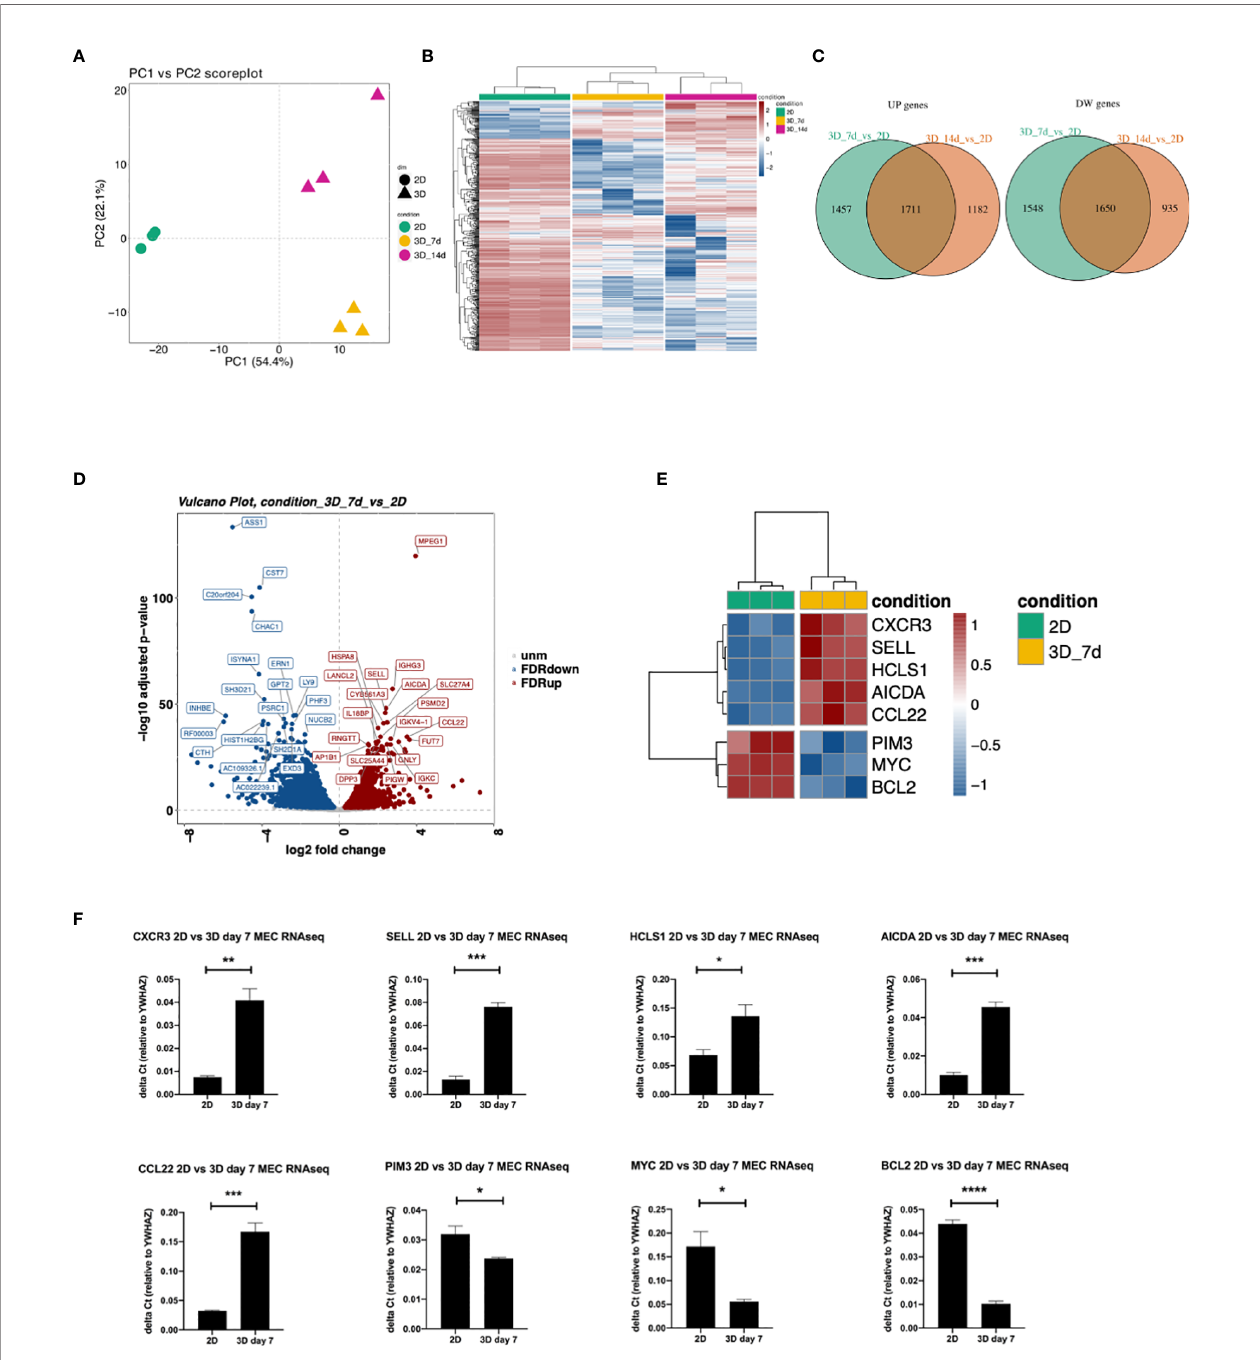
FIGURE 4 | Differences in gene expression between 3D bioprinted and 2D cultured MEC1 cells: clustering analysis and top genes validation. (A) PCA plot built using the 500 most variable genes (in RPKM). (B) Heatmap of the 500 most variable genes (in RPKM), clustering row (genes) and columns (samples). Expression is scaled. (C) Intersection between up-regulated (left) and down-regulated (right) genes between the comparisons 3D_7d_vs_2D and 3D_14d_vs_2D. (D) Vulcano plot for the comparison 3D_7d_vs_2D highlighting the 20 most signi fi cantly up-regulated (red) and down-regulated (blue) features for the FDR fi lter. (E) Heatmap summarizing genes among the fi rst 100 most modulated in the comparison 3D_7d_vs_2D. (F) The graphs show mRNA levels of n=8 genes selected among the fi rst 100 most modulated in the comparison 3D_7d_vs_2D which have been validated by RT-qPCR ( AICDA, SELL, CXCR3, CCL22, HCLS1, PIM3, MYC, BCL2 ). *p < 0.05, **p < 0.01, ***p < 0.001, ****p < 0.0001. Data are represented as mean ± SEM, n=3 MEC1 cell line samples. Student ’ s t-test was performed for statistical